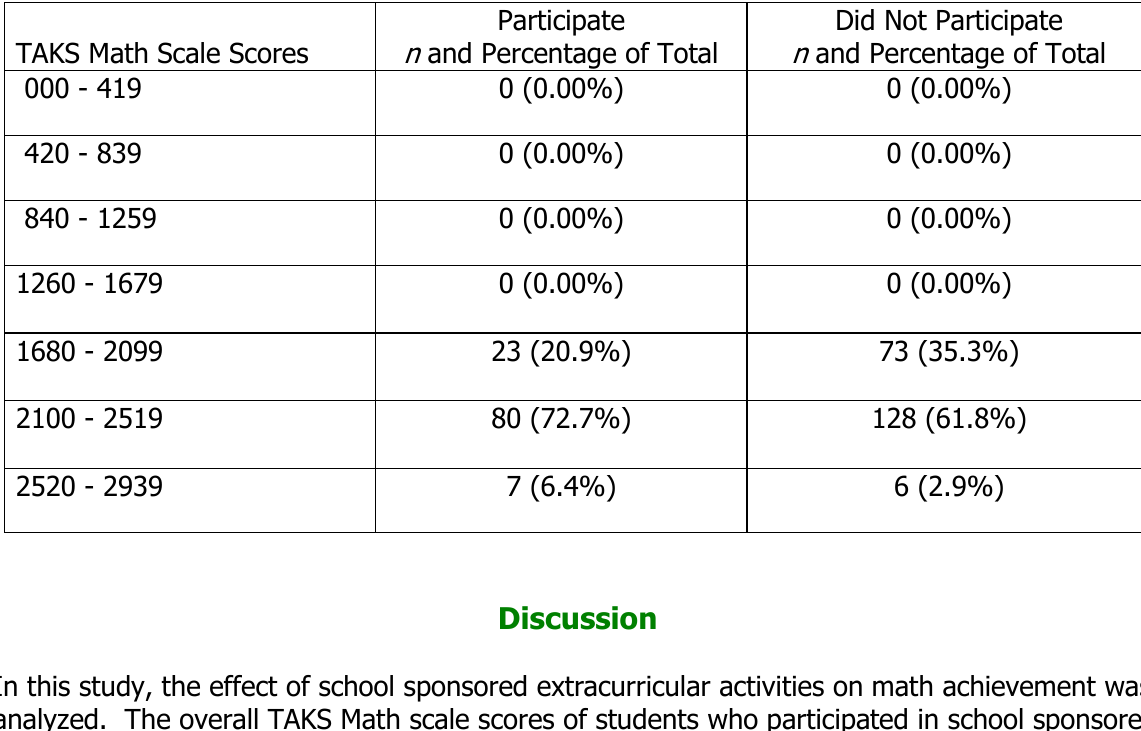
Frequency and Percentages of TAKS Math Scale Scores for Students Who Participated in School Sponsored Extracurricular Activities and Students Who Did Not Participate